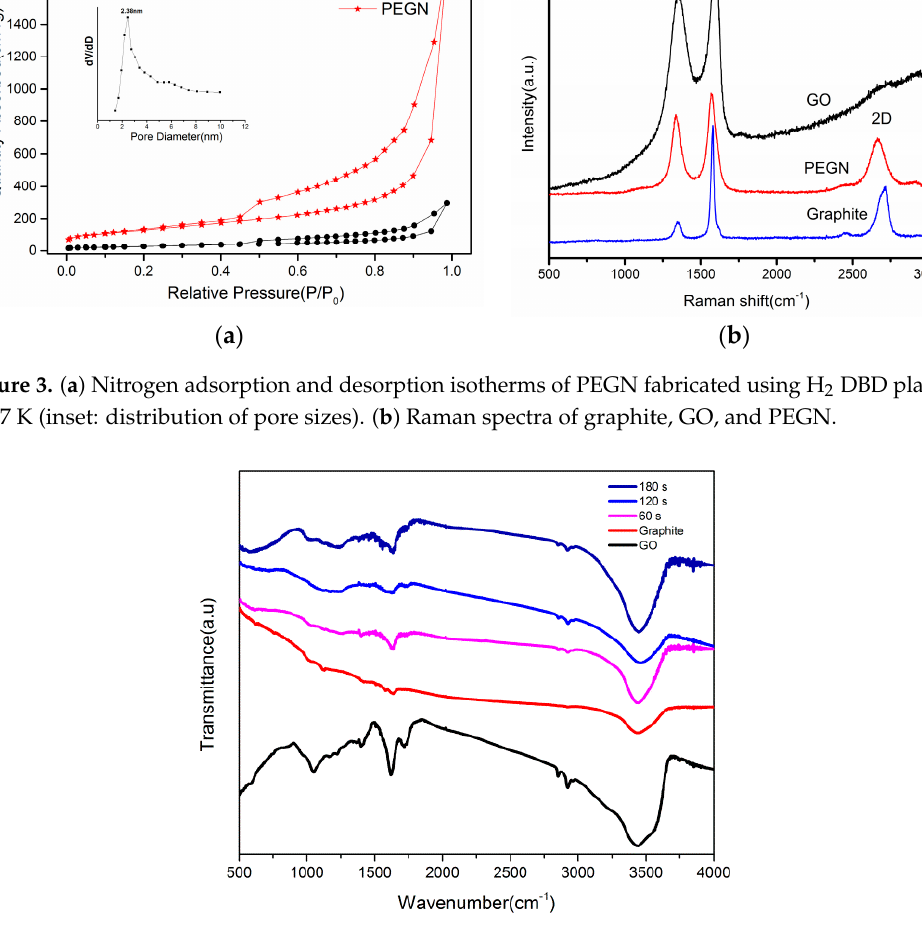
Figure 4. FT-IR spectra of GO, graphite, and the products of plasma treatment for 60, 120, and 180 s, respectively.